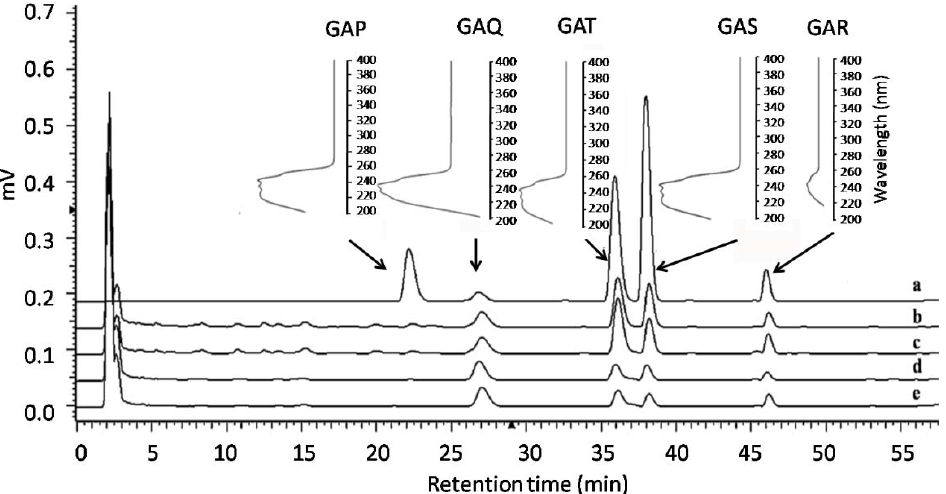
Figure 1. Structures of the five GA compounds isolated and used for content determination. Notes: OH: hydroxy group; OAc: acetoxyl group.